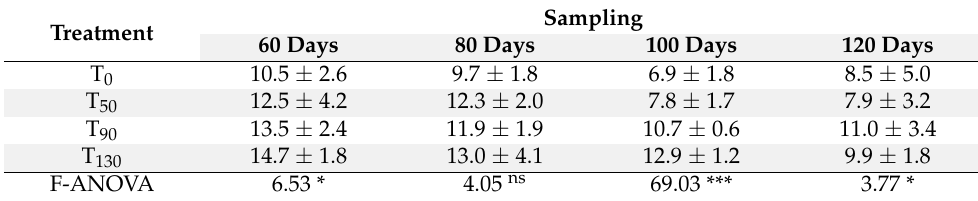
Table 6. Magnesium content (mg/L) in leachates. Entries represent means ± standard errors from n = 3 replicates.